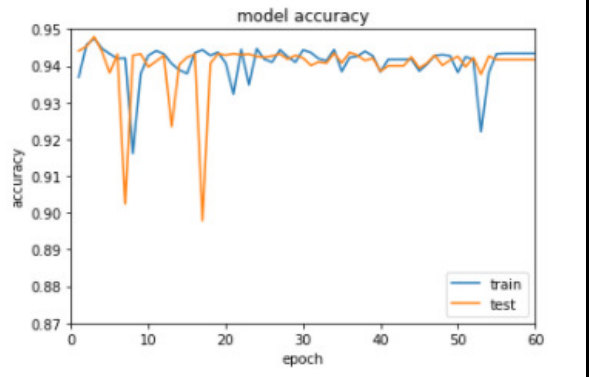
Fig.7: Accuracy of the model against unknown malware detection